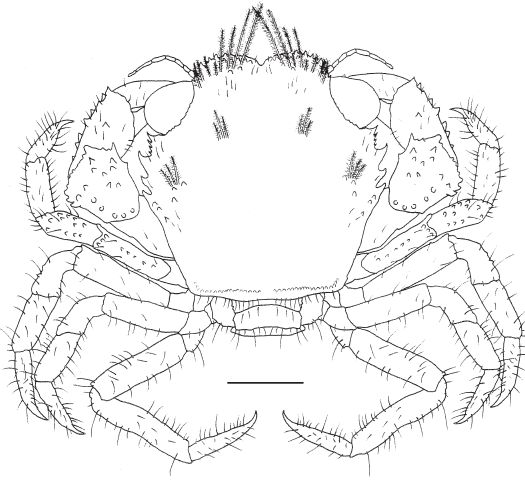
Fig. 9. – Pilumnoides hassleri . First crab, general